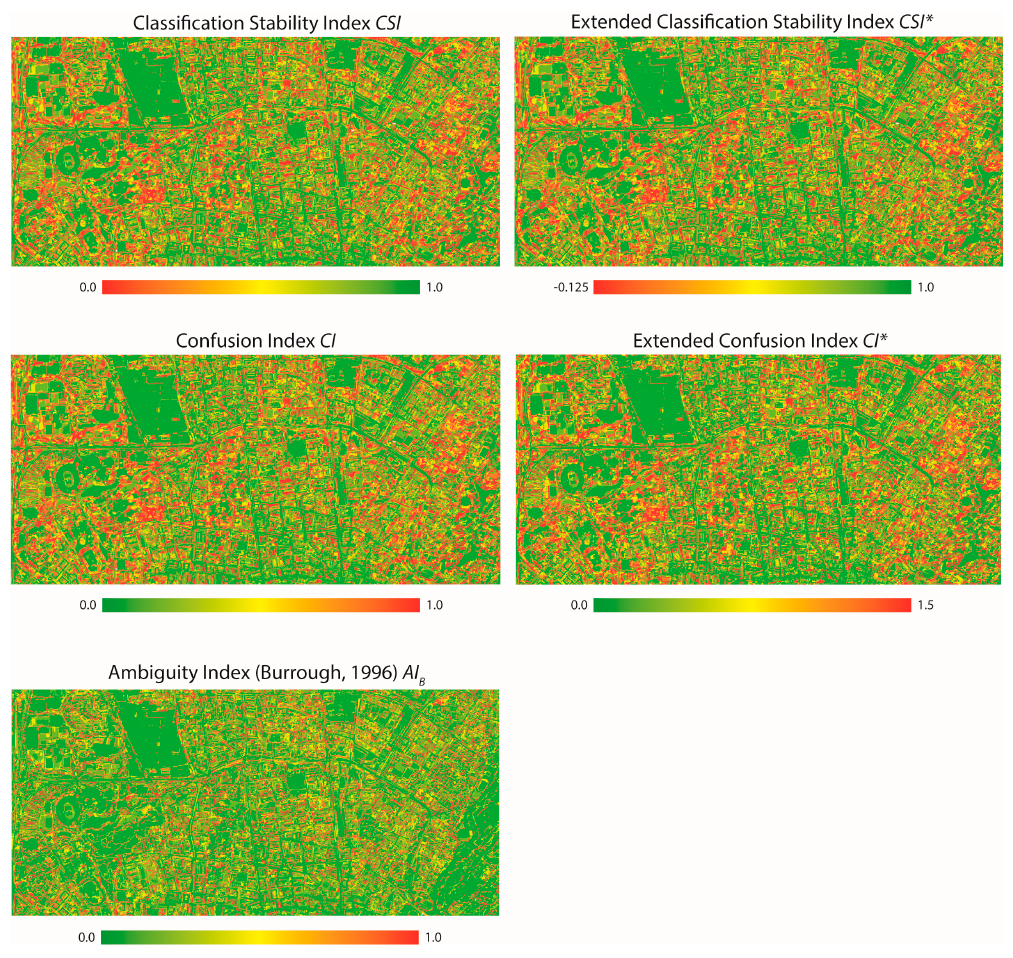
Figure B1. Measured values for the indices (see Section 2.2.3): CSI ( upper left ), CSI* ( upper right ), CI ( centre left ), CI* ( centre right ) and AI B ( bottom ) after segmentation and initial fuzzy classification ( L -Classes) of WV-2 scene of Munich as depicted in Figure 3.